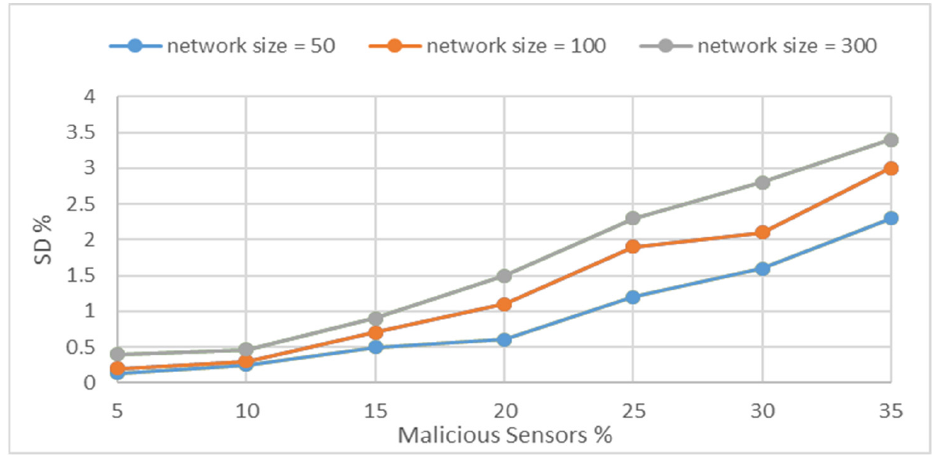
Figure 4. SD% vs. % malicious sensors in WSNs.